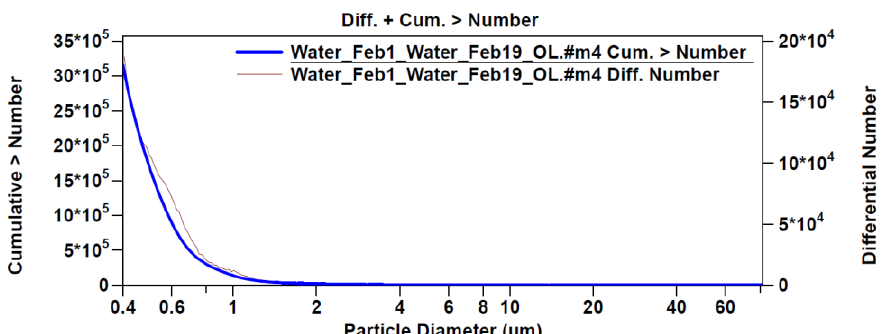
Figure 2. Cumulative number of particles in comparison to particle diameter.